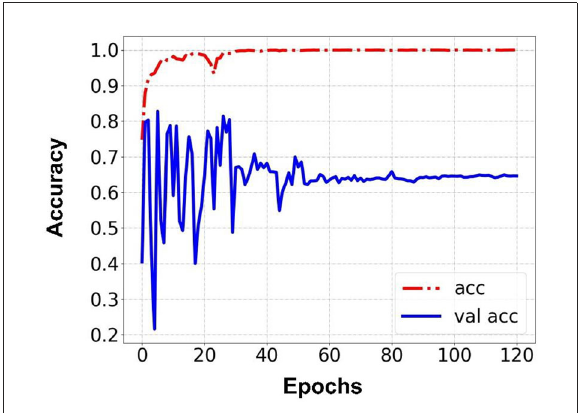
FIGURE2 Accuracy for Task 1 in an image.